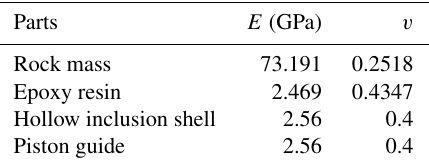
Table 6. Test results of mechanical parameters.